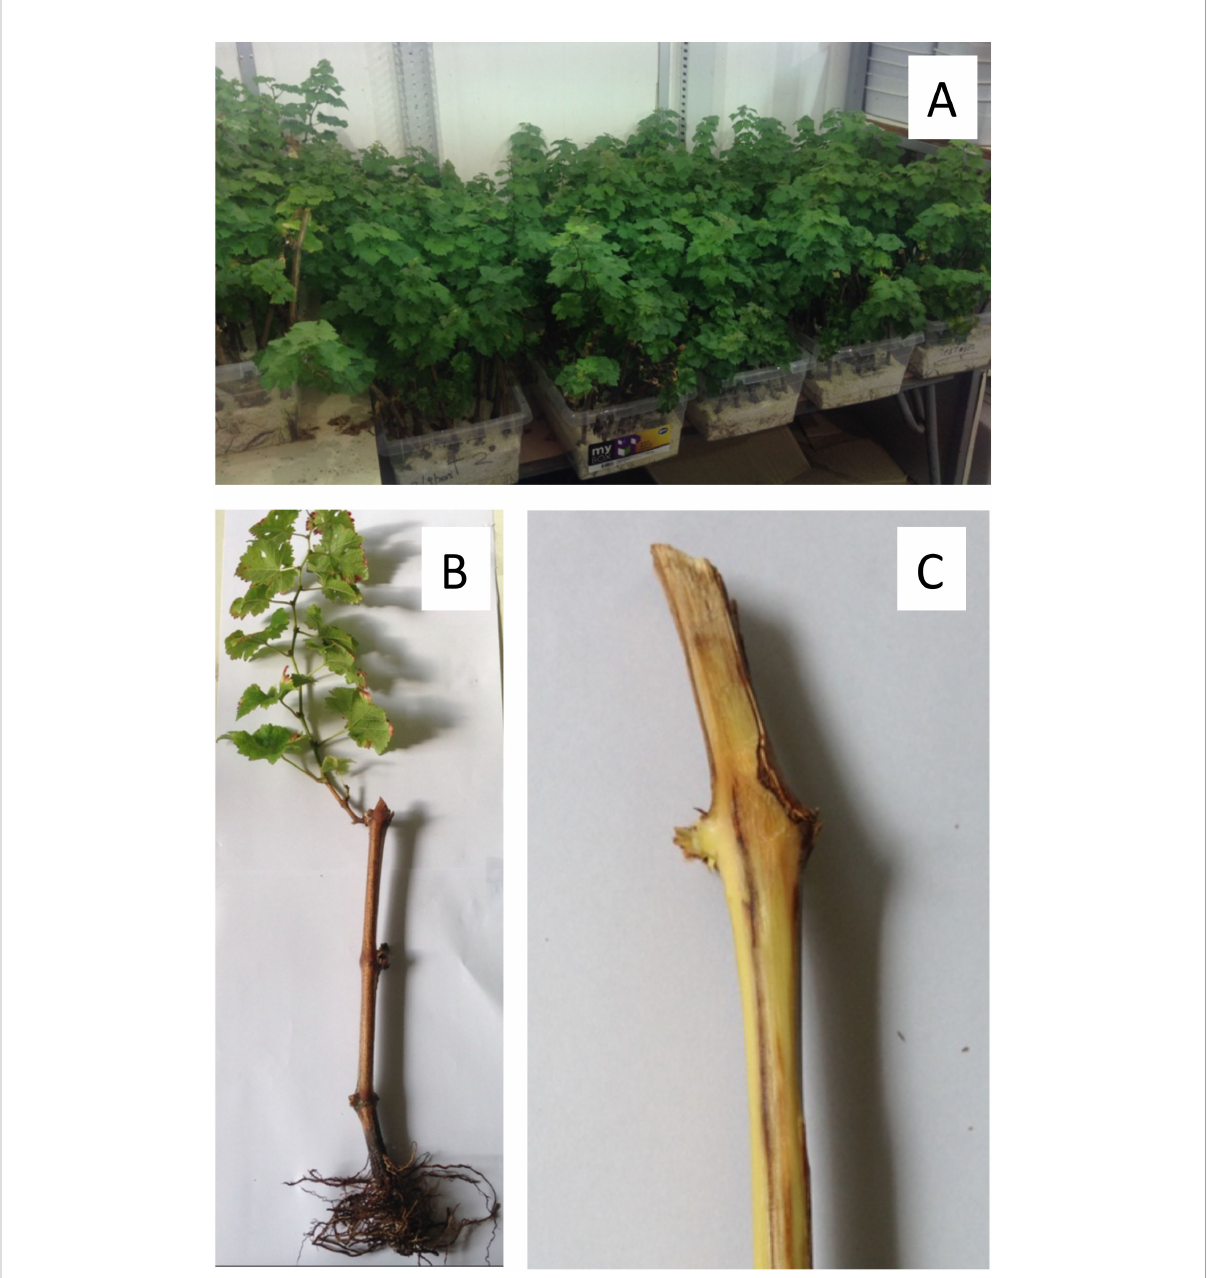
FIGURE 2 Rooted cuttings of one-year-old of grapevine cv. Cabernet Sauvignon inoculated with a conidial suspension of isolate Pach-3 of Phaeomoniella chlamydospora under greenhouse conditions (with temperature between 15-24°C and 70-85% HR) for four months. General view of part of grapevine cuttings after four months (A) . Apparently healthy grapevine cuttings inoculated with P. chlamydospora showed green shoots and root system (B) . Grapevine cutting shows vascular discoloration, which was inoculated one day after pruning (C)